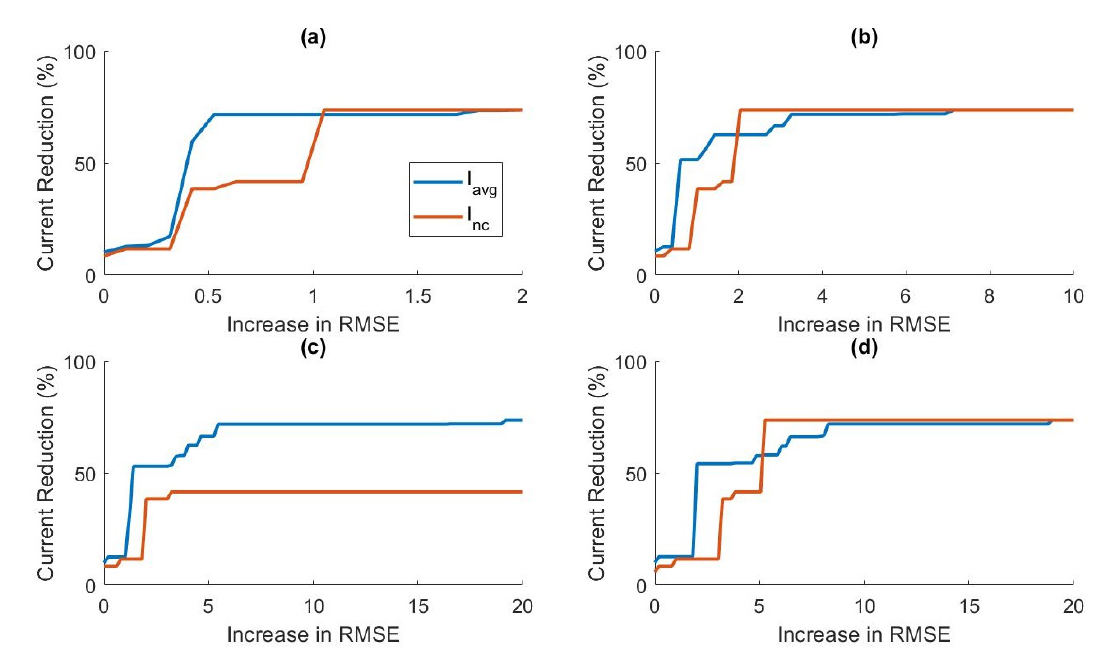
Figure 9. The effect of increasing allowable prediction RMSE on the average current consumption across clusters, I avg , and no clustering, I nc for: ( a ) δ h = 10; ( b ) δ h = 30; ( c ) δ h = 60; and ( d ) δ h = 90.